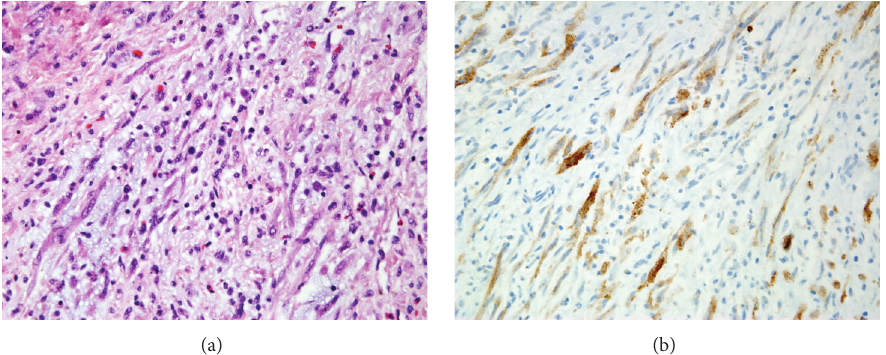
Figure 2: (a) Hematoxylin and eosin stain of the bladder mass showing features consistent with IMT. Spindle cells and nuclear atypia are seen in a background of mixed inflammation with variable myxoid stroma. (b) ALK immunohistochemistry of the bladder mass showing cytoplasmic positivity in spindle cells. The identification of ALK suggests a neoplastic process and distinguishes IMT from other spindle cell lesions, which do not express ALK. The ALK protein is detectable in about 50% of